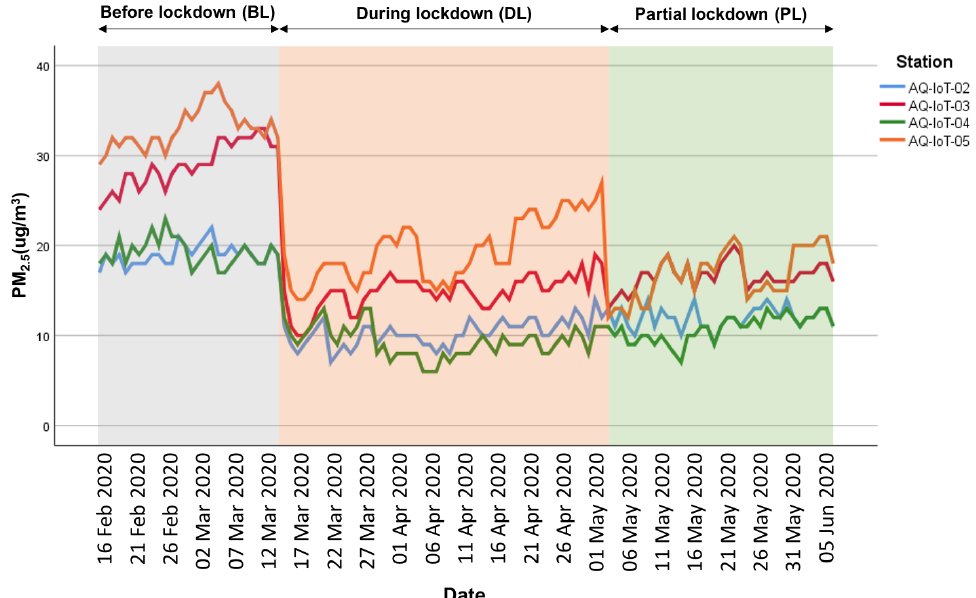
Figure 1. Daily (24 h) average concentrations of PM 2.5 between February 16 and June 5 in Victoria, Mexico (in highlighted sections, the different periods are